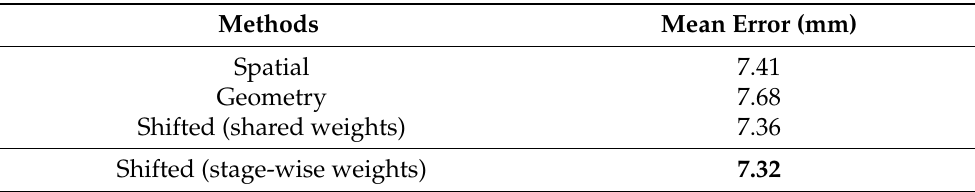
Table 3. Comparison of different